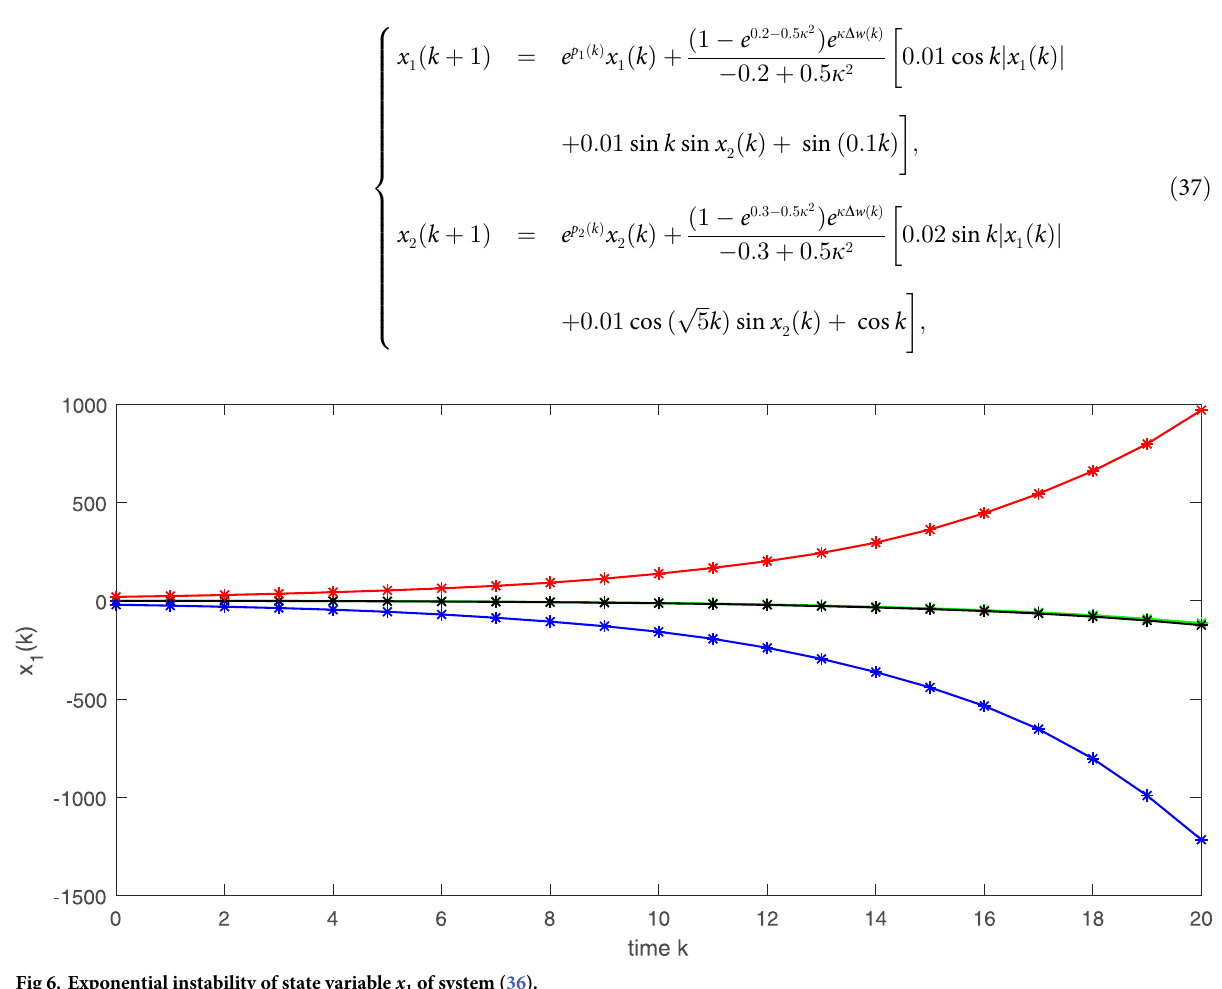
Fig 6. Exponential instability of state variable x 1 of system (36).